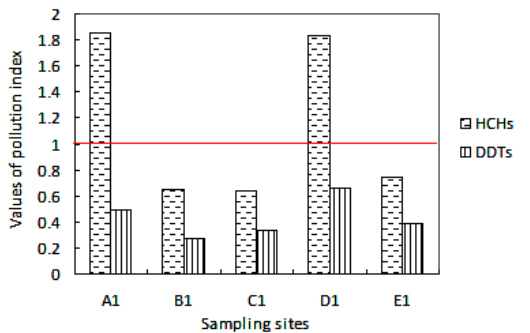
Fig. 5. Comparison of soil pollution index values of